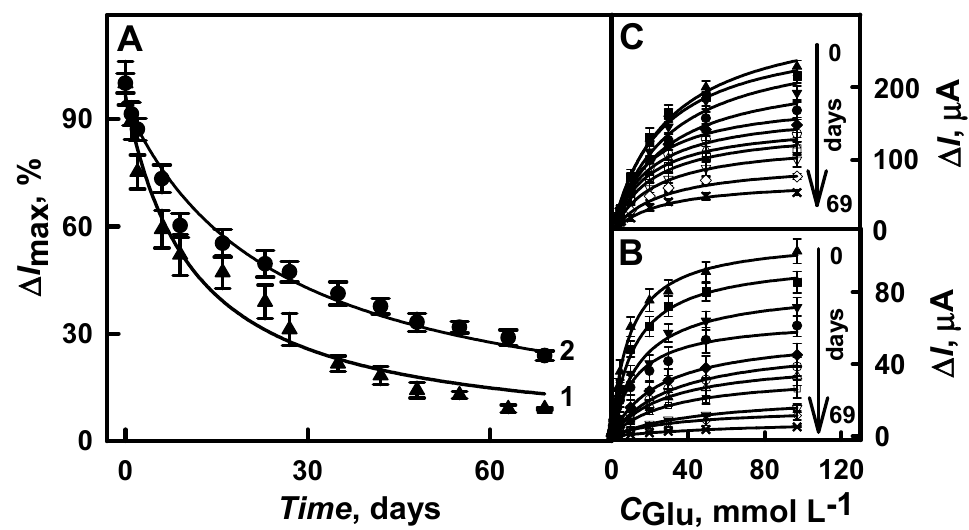
Figure 8. The stability ( A ) and calibration plots of GOx/GR (1 curve and B ) and GOx/DGNs/GR (2 curve and C ) electrodes. Amperometric response was measured in 0.05 mol L − 1 SA buffer with 0.1 mol L − 1 KCl (pH 6.0) and 2.0 mmol L − 1 PMS.